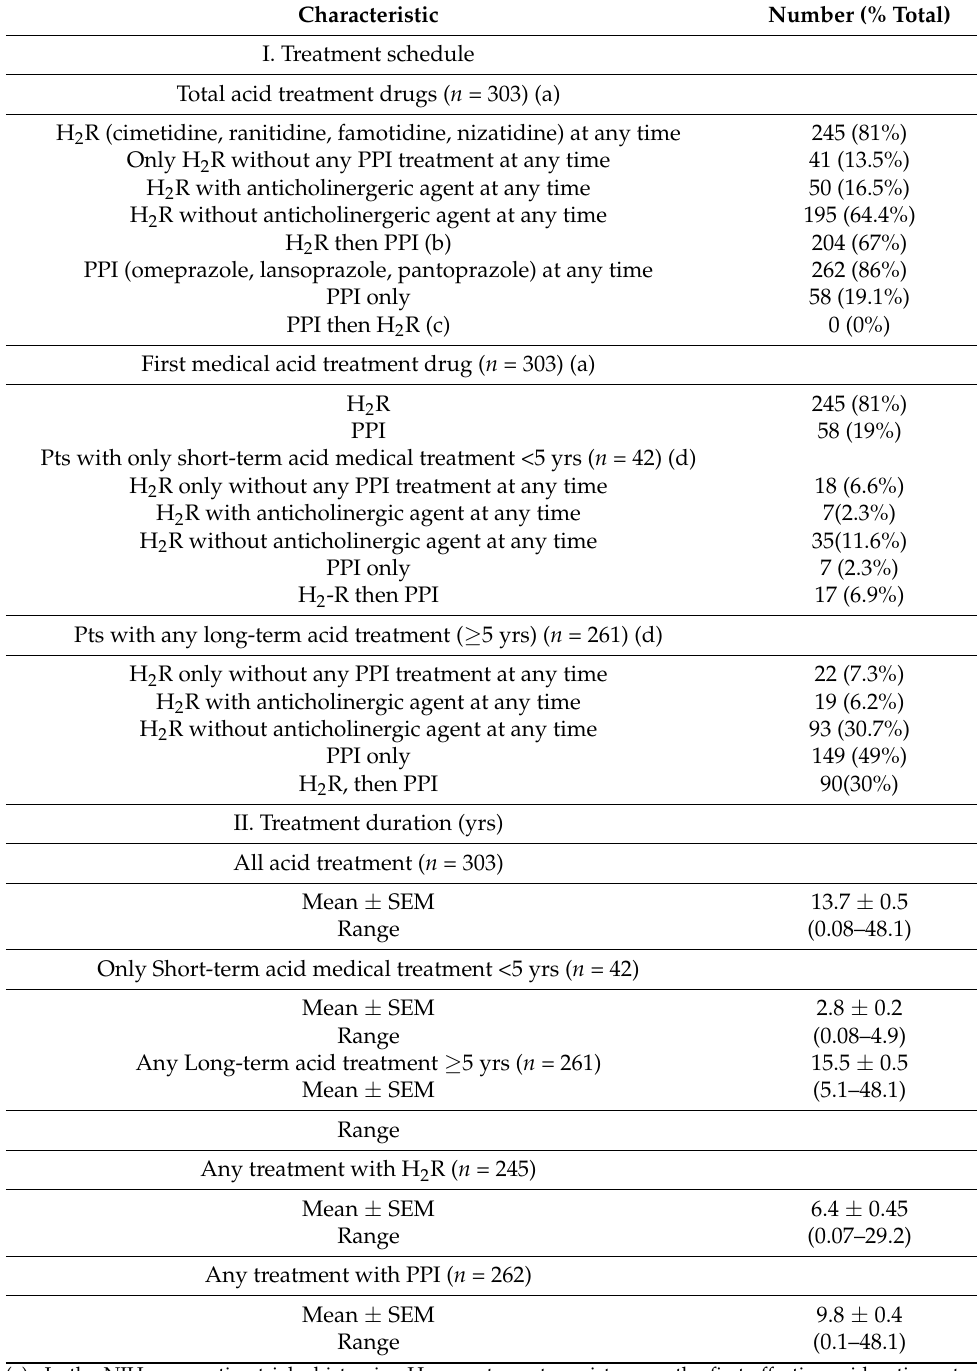
Table 3. Acid treatment: Schedule and